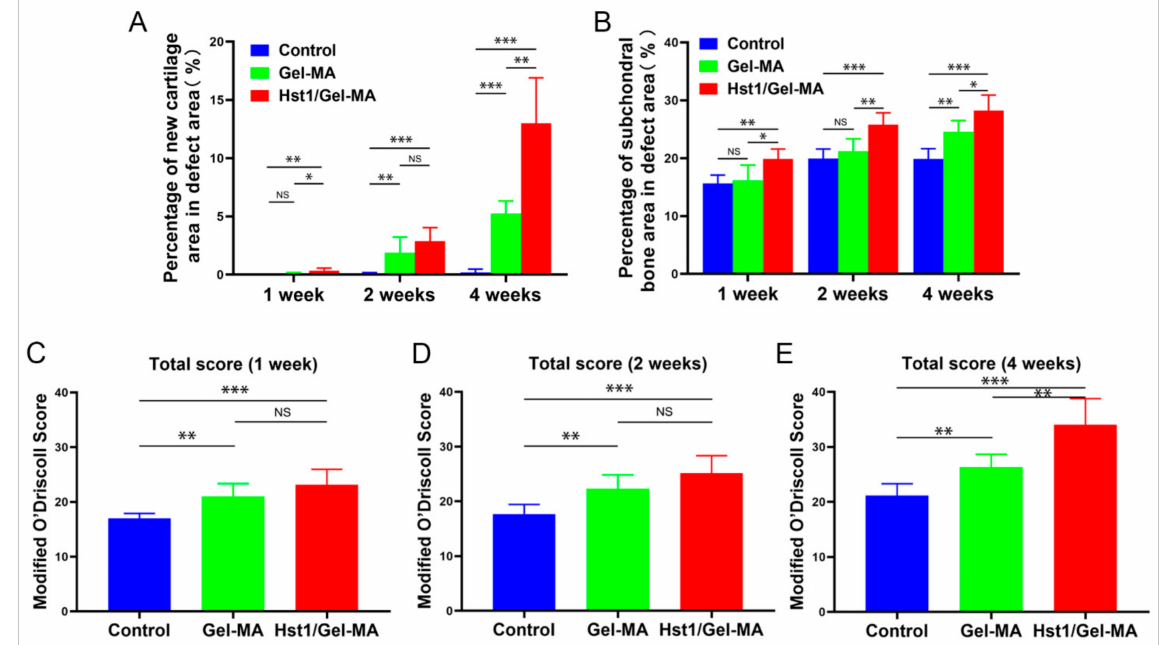
Figure 3. Quantitative analysis of newly formed cartilage ( A ) and subchondral bone area ( B ), and the MODS evaluation for repaired osteochondral defects at 1, 2, and 4 weeks postimplantation ( C – E ). ( n = 6, * p < 0.05, ** p < 0.01, *** p < 0.001 and NS = not